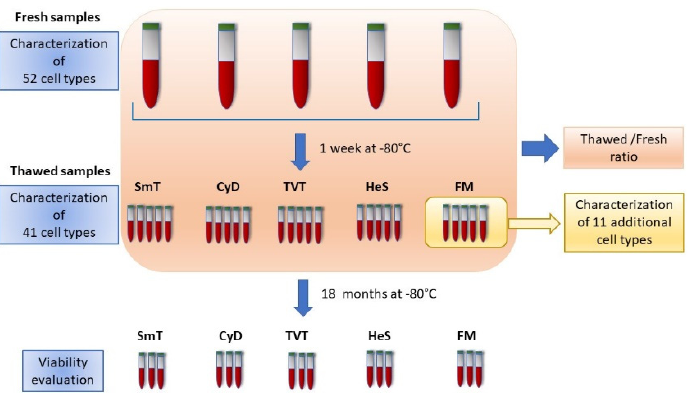
Figure 1. Flow diagram of the study approach. Five blood samples were characterized for 41 im- munophenotypes in fresh and matched thawed samples one week after freezing. Eleven additional immunophenotypes were measured in fresh blood and after their freezing by FM method. Thawed and fresh samples were compared by thawed/fresh ratio. Viability was assessed in three samples per method 18 months after storage. SmT: Smart Tubes; CyD: CytoDelics; FM: Freezing Mix; HeS: HetaSep; TVT: TransFix/EDTA Vacuum